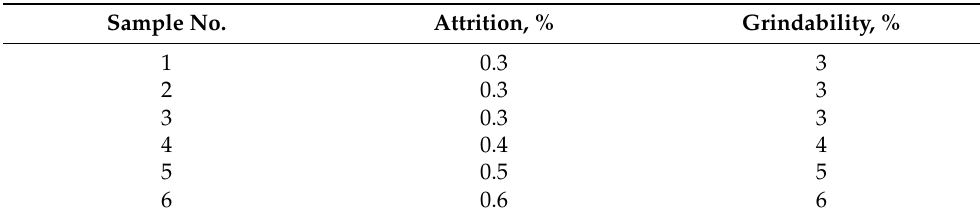
Table 2. Mechanical characteristics of the experimental samples of the granulated GO-Ch composites.